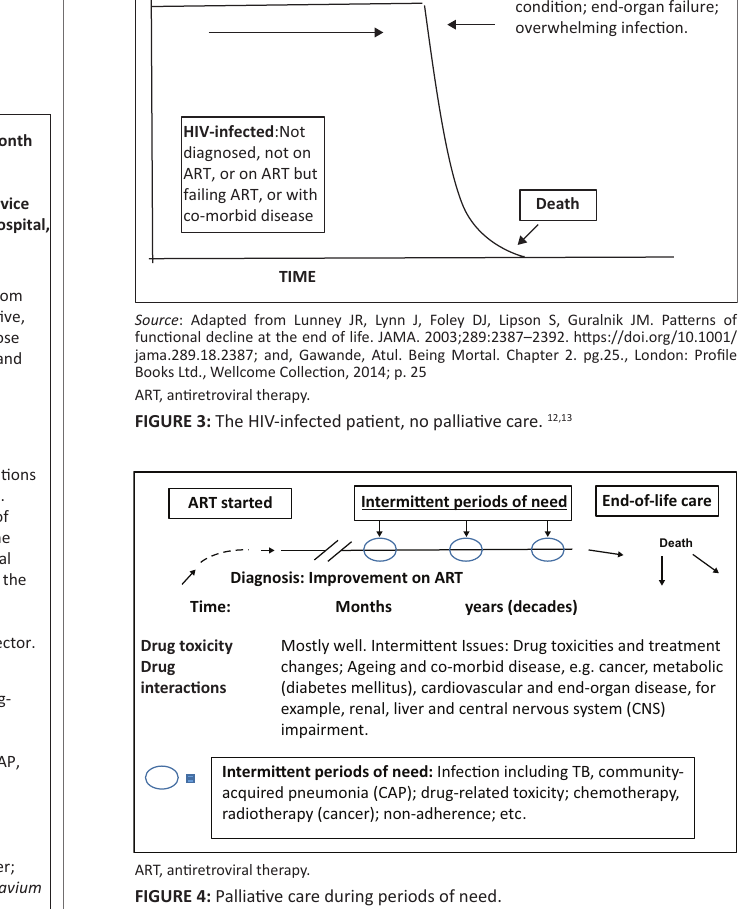
FIGURE 4: Palliative care during periods of need.